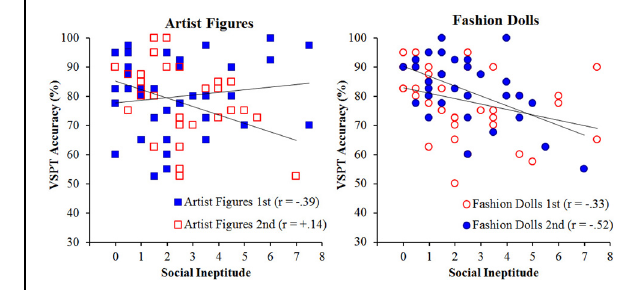
FIGURE 6 | VSPT performance as a function of social ineptitude score separately for the artist figures (left) and fashion dolls (right) conditions broken out by order for Experiment